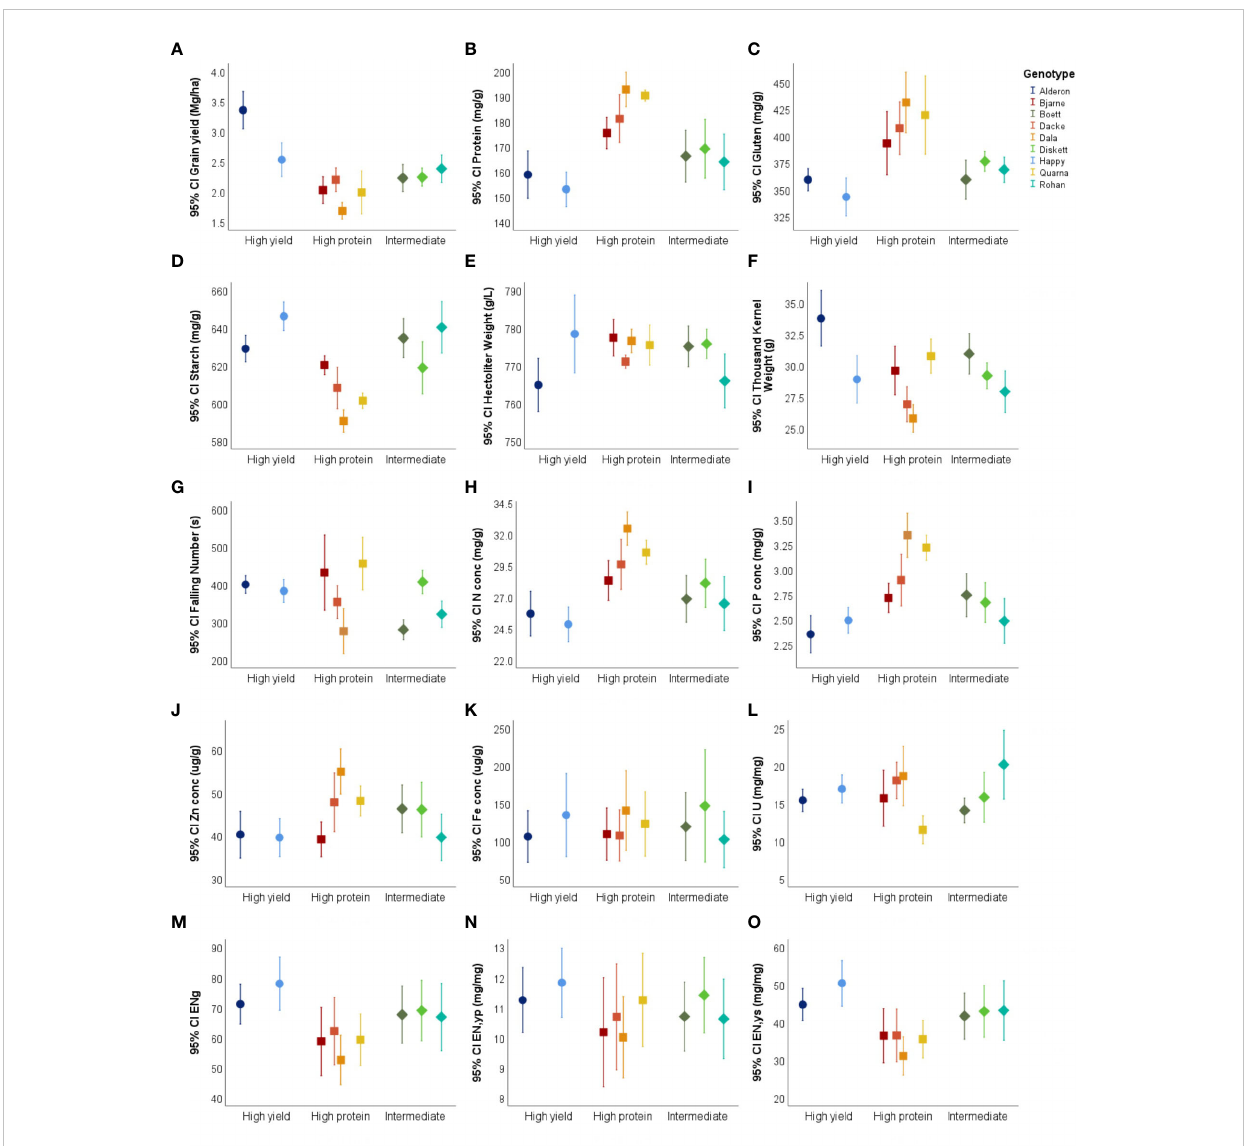
FIGURE 4 Mean values and con fi dence interval at 95% of fi fteen traits (A) Grain yield, (B) Protein, (C) Gluten, (D) Starch, (E) Hectoliter Weight, (F) Thousand Kernel Weight, (G) Falling Number, (H) N conc, (I) P conc, (J) Zn conc, (K) Fe conc, (L) U, (M) EN, (N) EN,yp, and (O) EN,ys of nine spring heat varieties divided by their breeding target in Uppsala, Sweden for combined years (2018 & 2019). Wheat groups High yield wheat type (I), Organic high protein wheat type (II), and Intermediate wheat type (III). Trait abbreviations N conc Nitrogen concentration, P conc Phosphorus concentration,